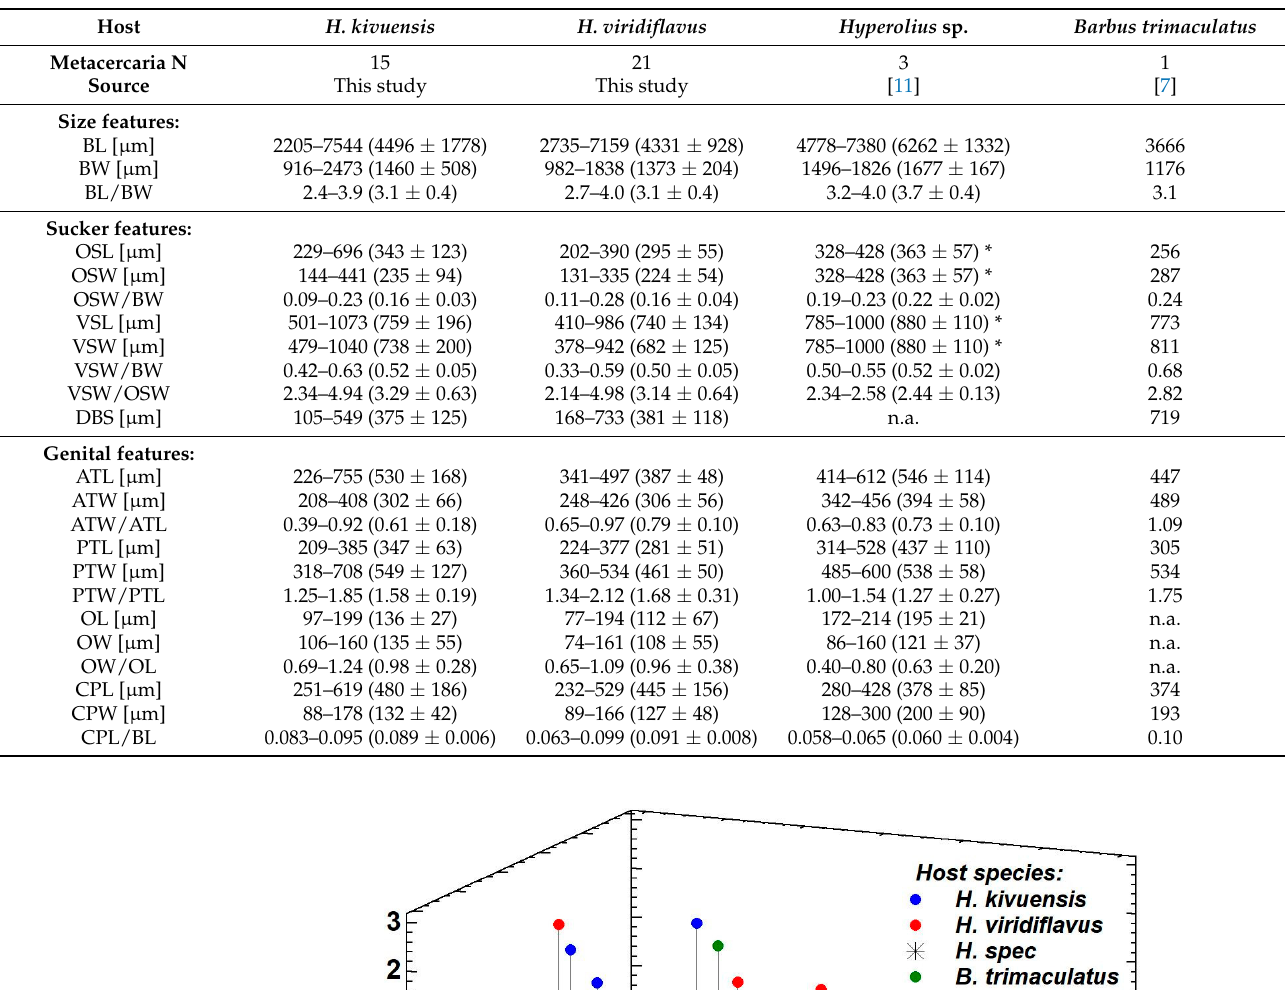
Table 3. Morphometric features of Clinostomum chabaudi metacercariae collected from different host species. Data are given as the minimum-maximum range, arithmetic mean and corresponding standard deviation. Abbreviations: BL = Body Length, BW = Body Width, OSL = Oral Sucker length, OSW = Oral Sucker Width, VSL = Ventral Sucker length, VSW = Ventral Sucker width, DBS = Distance between Sucker, ATL = Anterior Testis Length, ATW = Anterior Testis Width, PTL = Posterior Testis Length, PTW = Posterior Testis Width, OL = Ovary Length, OW = Ovary Width, CPL = Cirrus Pouch Length, CPW = Cirrus Pouch Width. * measurements given as diameter; n.a. = not available.